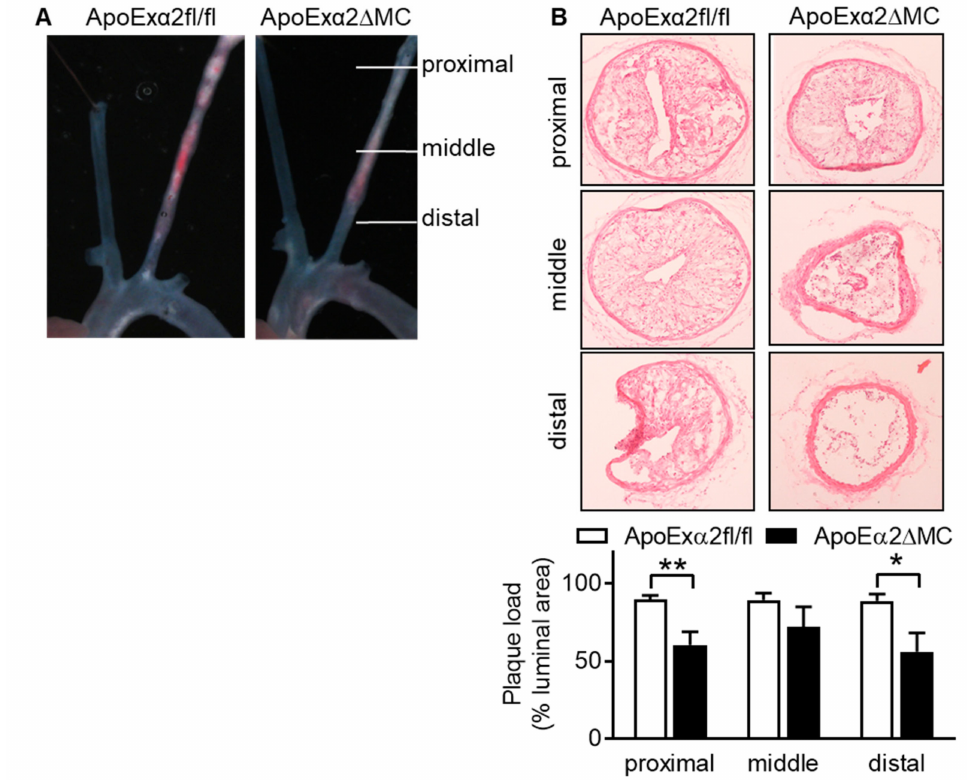
Figure 6. E ff ect of myeloid cell specific AMPKa2 deletion on plaque formation after partial carotid artery ligation. Three weeks after partial ligation, the left carotid artery in ApoEx α 2 fl / fl and ApoEx α 2 ∆ MC mice carotid arteries were dissected. ( A ) Representative images of plaques in the intact carotids. The images shown are representative on an additional four animals in each group. ( B ) Representative cross sections of the ligated carotid at di ff erent distances from the ligation site. Side bar = 100 µ m. The bar graph summarizes the plaque load (% of total luminal area); n = 4–5 animals per group (Student’s t test). * p < 0.05, ** p <